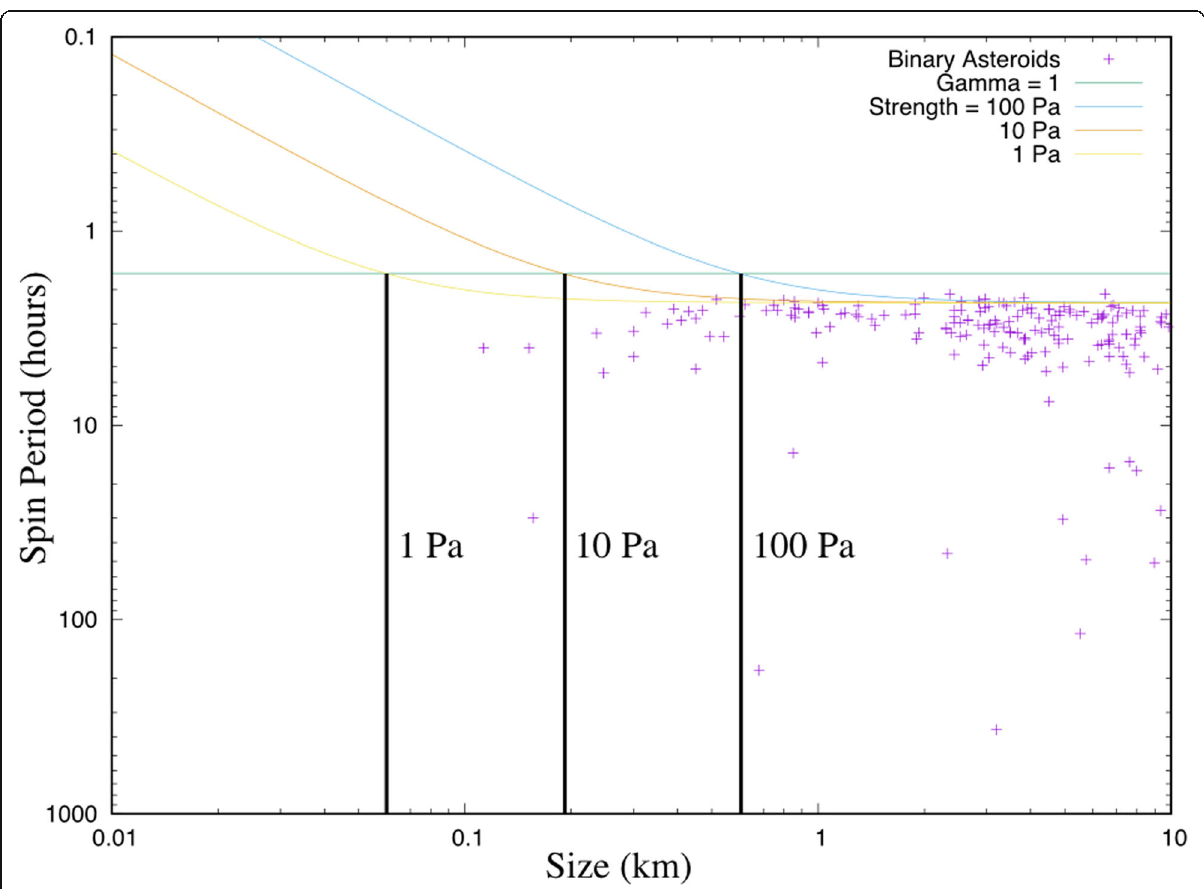
Fig. 3 Observed binary asteroid primary spin periods vs estimated diameters. Data taken from Warner et al. (2009). The vertical lines indicate where different strength levels cross the Γ = 1 line, which demarcates the ideal transition between the binary formation and abrupt binary